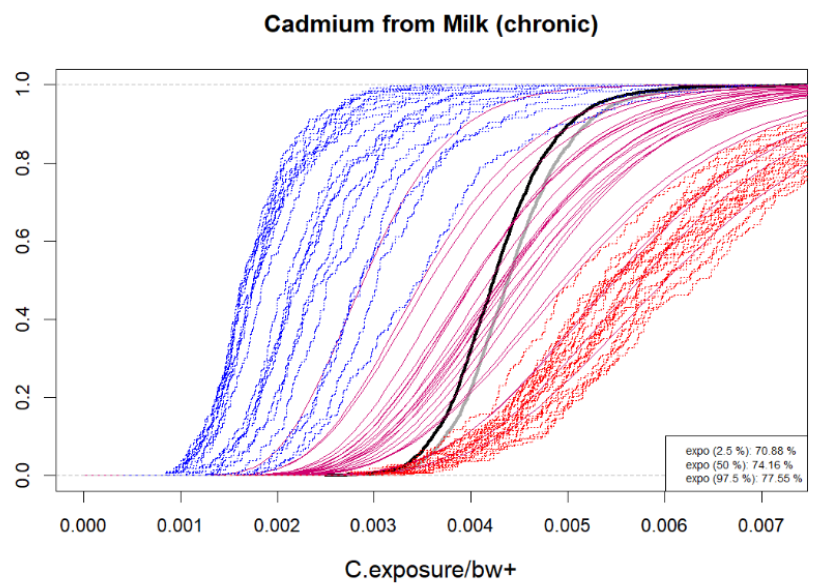
Figure 4. Example cumulative distributions of chronic exposure per body weight from contaminated food on consumption days. A sample of probable exposure distributions (magenta) and the uncer- tainty distributions for exposure mean (gray) and median (black). Monte Carlo pseudo empirical cumulative distributions produced for a few bootstrapped data sets with lowerbound/upperbound substitution of censored measurements (blue/red). Estimated exposure frequency is given numeri- cally (i.e., proportion of days when contaminated food is consumed). Numerical values on horizontal axis depend on the measurement unit used in the user’s